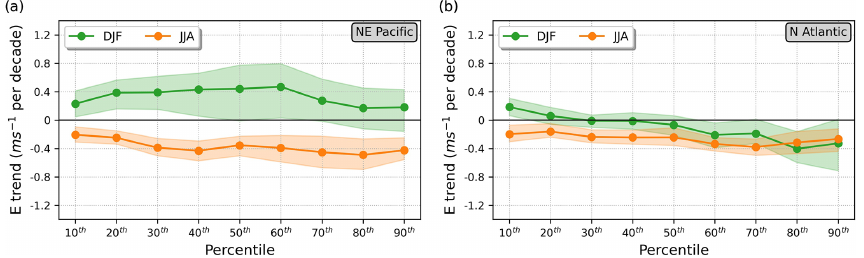
Figure 5. (a) Graph of 1979–2019 linear trends (Theil–Sen estimator; connected dots) in 9 percentiles of the DJF (green) and JJA (orange) NE Pacific 5-year PDFs (Fig. 4a, c) of daily-mean E at 300hPa in ERA5. The shading indicates the 90% confidence interval. (b) Same as panel (a) , but for the N Atlantic